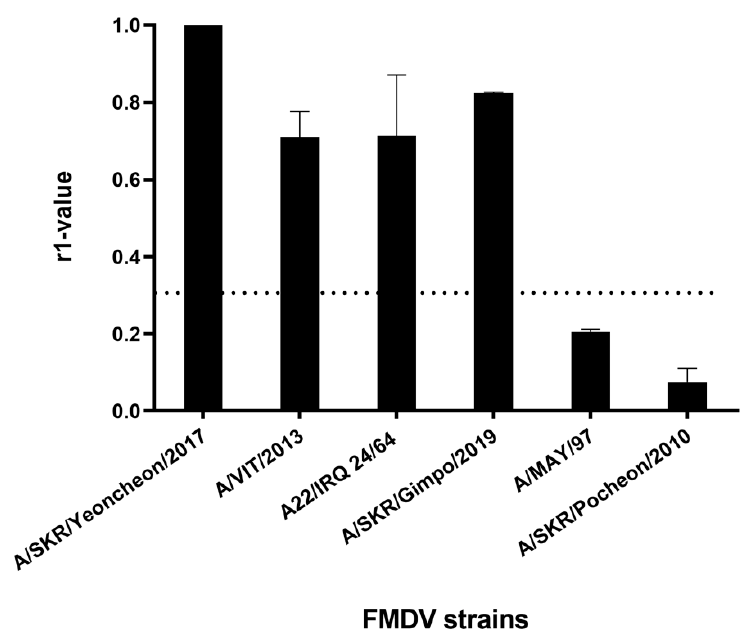
Figure 5. Serological cross-reactivity against heterologous viruses. A two-dimensional (2D) virus neutralization test (VNT) was performed using sera from cows vaccinated with the A/SKR/Yeonch- eon/2017 (A-1) experimental vaccine and field viruses including A/SKR/Yeoncheon/2017 (A/ASIA/Sea-97-G2, homologous field virus), A/VIT/2013 (A/ASIA/Sea-97), A22/IRQ/24/64 (A/ASIA), and